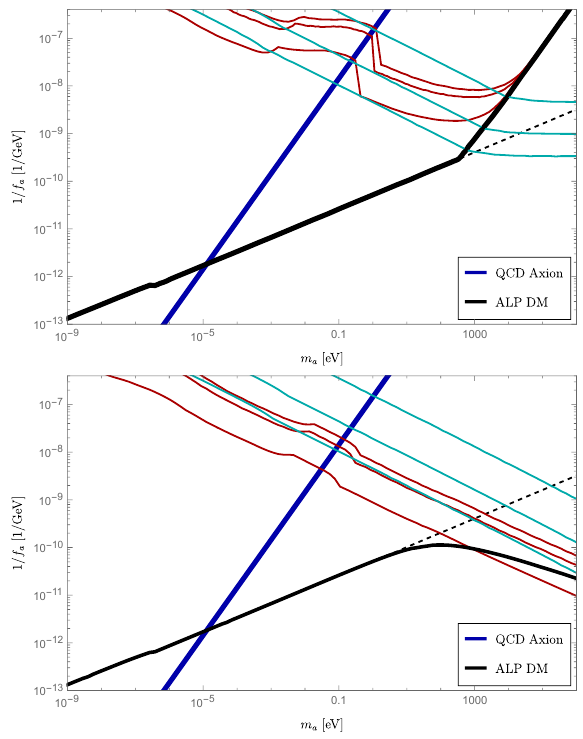
Figure 3 . Predictions for the values of { m a , 1 /f a } that reproduce the correct axion DM relic den- sity (black solid lines), taking into account thermal friction for α = 0 . 2 ( top panel ) and α = 0 . 4 thr thr ( bottom panel ). They deviate with respect to the standard frictionless computation, which is shown in dashed black lines. The red lines are constant depletion factor e − D , with D defined in eq. (3.15) and correspond to 10 − 20 , 10 − 10 , 10 − 1 from top to bottom. The cyan lines are lines of constant enhancement factor ( m 4 H ) 3 / 2 and correspond to 100, 10, 2 respectively from top to osc / osc